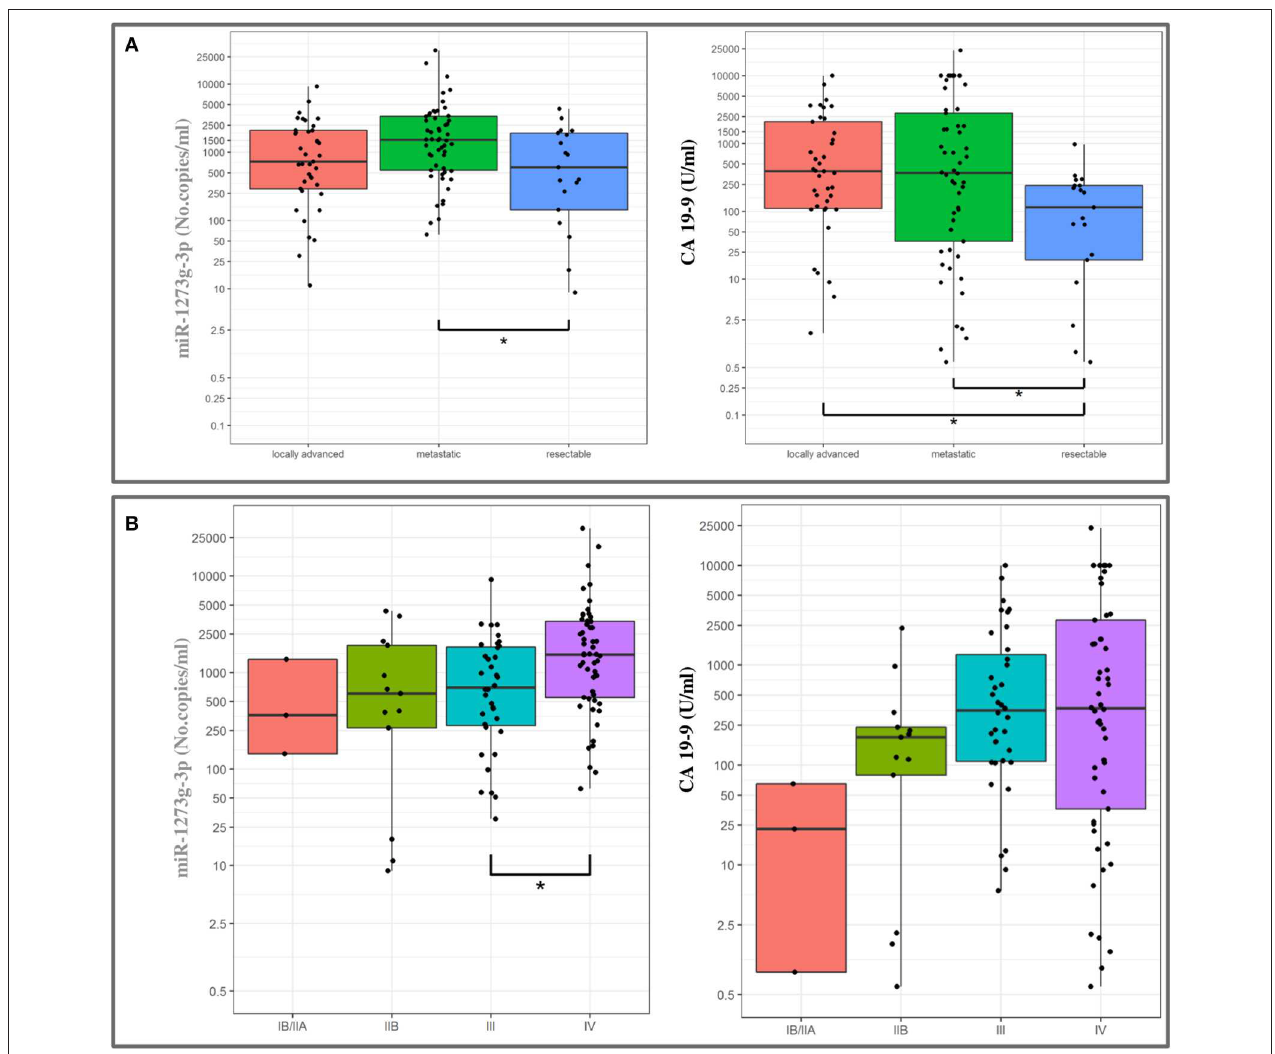
FIGURE 5 | Association between miR-1273g-3p plasma levels and CA 19-9 values with pre-operative classification (A) and tumor stage (B) in patients with pancreatic cancer (boxplots). The ends of each box are the upper and lower quartiles, so the box spans the interquartile range (IQR), whereas the median is marked by a horizontal black line inside the box. The whiskers are the two lines outside the box that extend to the highest and lowest plotted observations (black dots). Values are reported in log scale